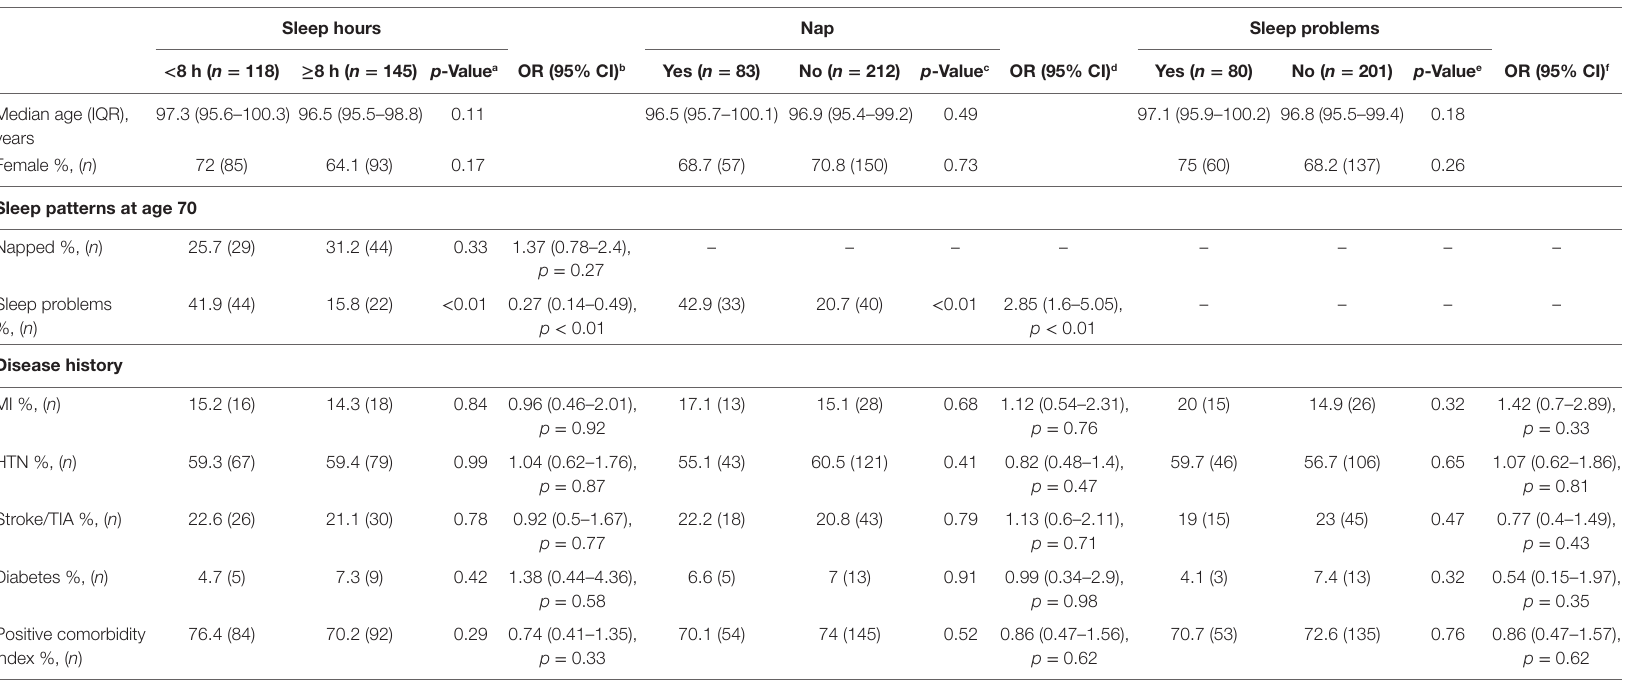
TaBle 2 | Centenarians’ sleep patterns at age 70 and disease history at